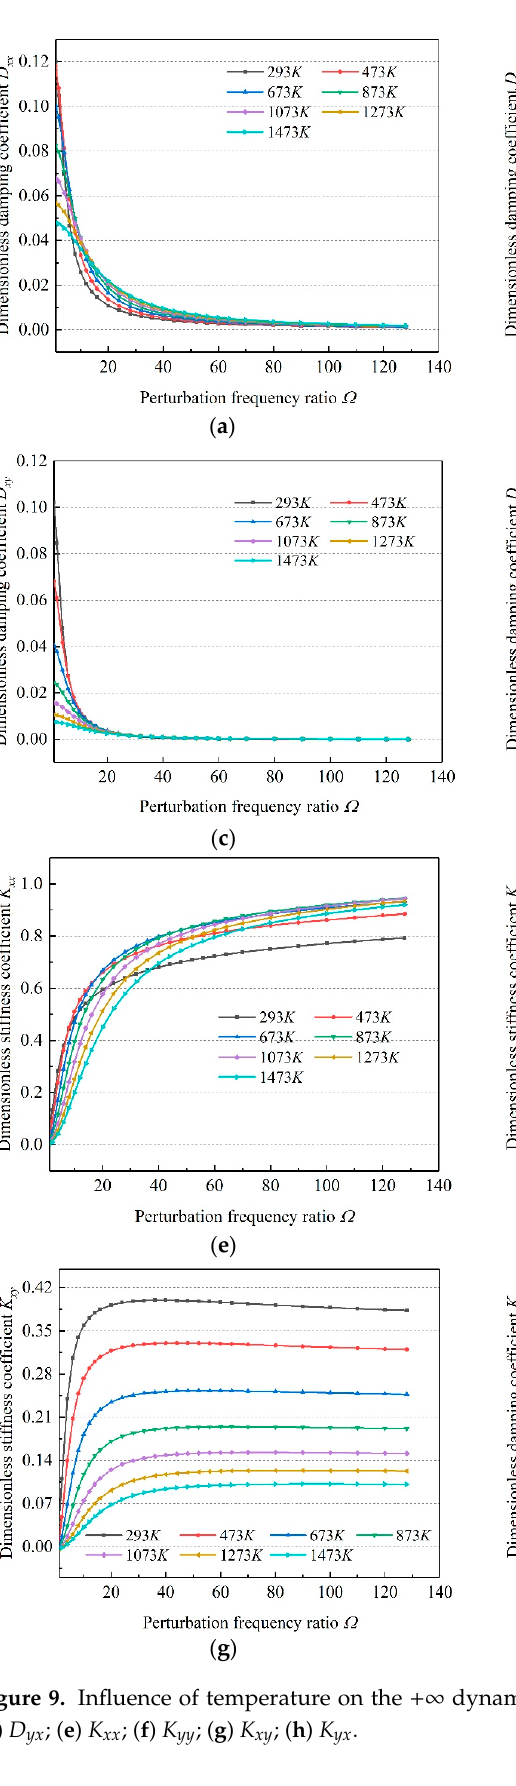
12 of 19 Figure 8. variation of dynamic coefficients.( a ) direct damping coefficients; ( b ) cross damping coefficients; ( c ) direct stiffness coefficients; ( d ) cross stiffness coefficients; When the temperature range was between 293 and 1473 K, for air, N 2 and CO 2 , D xx increased first and then decreased with the increase in temperature, while for gas bearing lubricated by He, D xx decreased. D yy decreased in all the cases with the increase in temperature. D xy decreased for all the cases generally, but for CO2 gas bearing, D xy increased slightly when temperature changed from 293 to 473 K. D yx decreased for microbearings lubricated by He, while the other three showed a slightly upward trend in the temperature range of 293 to 500 K, and then decreased. As for the dimensionless stiffness coefficients, the values of K xx , K yy , K xy and K yx showed a downward trend in all cases, and their values were positively related to the molecular mass of the gas. That is, the dimensionless stiffness coefficients of CO 2 gas bearing were the largest, while those of He were smaller in general. As the physical properties of N2 and air were similar, the dynamic performance of these two kinds of gas showed a similar change regular. The decrease in stiffness meant the capacity of microbearings decreased, which implied that with the ascending temperature, microbearings could not operate normally in the given loading case. The change of damping meant the stability of gas-lubricated microbearings changed correspondingly. When the gas bearing operated in a very high temperature, the damping of bearing decreased obviously, which indicated that the stability decreased. That is why, when the bearing operates in a high temperature condition, the stability should be paid much more attention for the normal working of gas bearing. 3.3. Effect of Temperature on + ∞ Dynamic Limit Characteristics of Microbearings The dynamic limit characteristics of gas-lubricated microbearings were an important part for the investigation of the stability of the bearing and dynamic characteristics. In this section, the partial derivative method was used to solve bearing ′ s + ∞ dynamic limit characteristic, and the dynamic characteristic of microbearings was obtained in the case that the perturbation frequency ratio ( Ω ) approached to + ∞ . The change curves of eight dynamic coefficients of microbearings lubricated by air when Ω changed from 1 to 128 at different temperatures are shown in Figure 9. It can be found that when Ω increased, the dimensionless stiffness coefficients and damping coefficients of gas bearing gradually